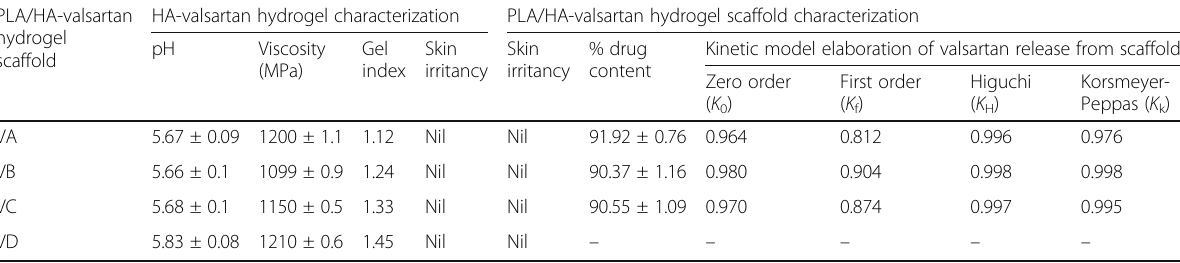
Table 2 Physicochemical characterization of PLA/HA-valsartan hydrogel scaffolds PLA/HA-valsartan HA-valsartan hydrogel hydrogel scaffold